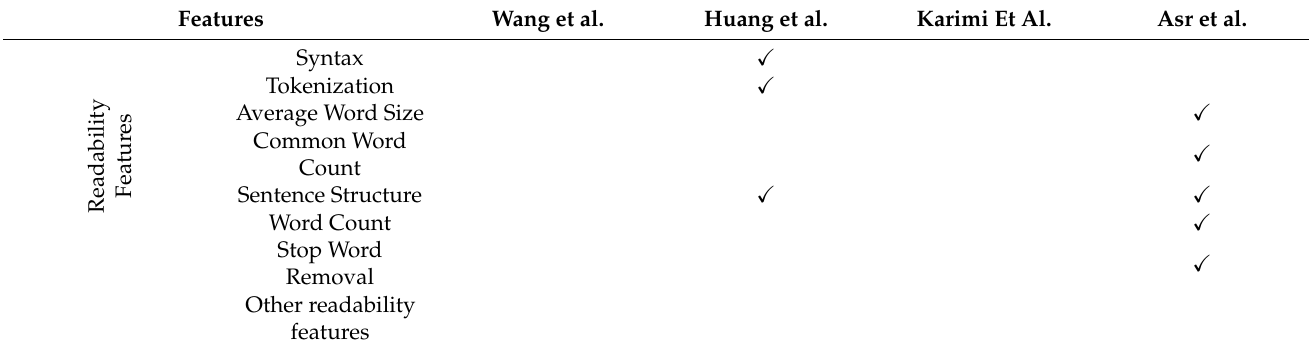
Table 13. Data Pre-Processing Features Used by Cross-Source